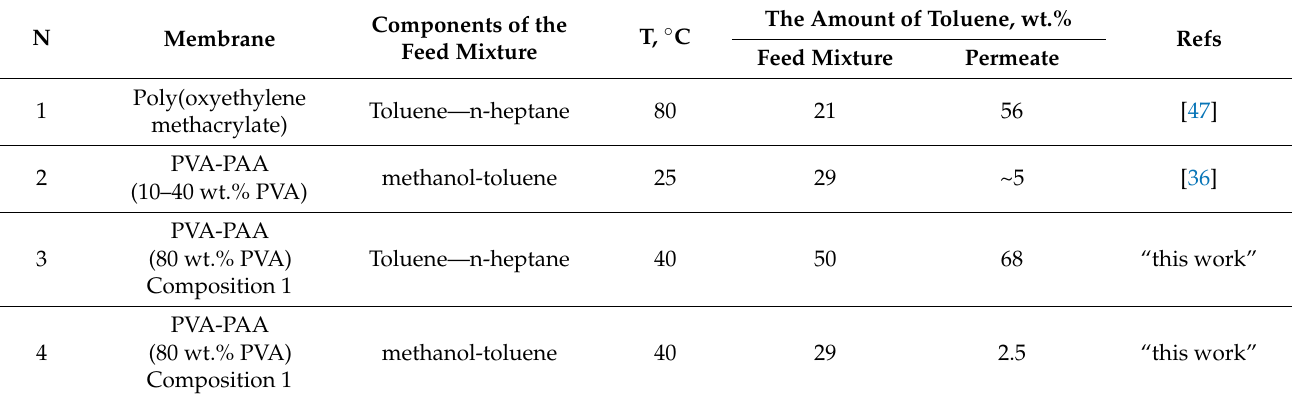
Table 2. Separation characteristics of the membranes obtained in the present work and their analogues described in the